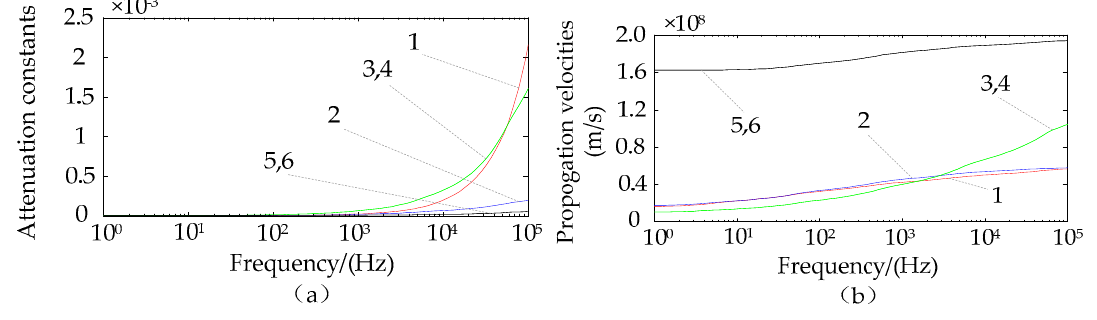
Figure 6. Attenuation constants and propagation velocities of the mode currents. ( a ) Attenuation constants. ( b ) Propagation velocities.